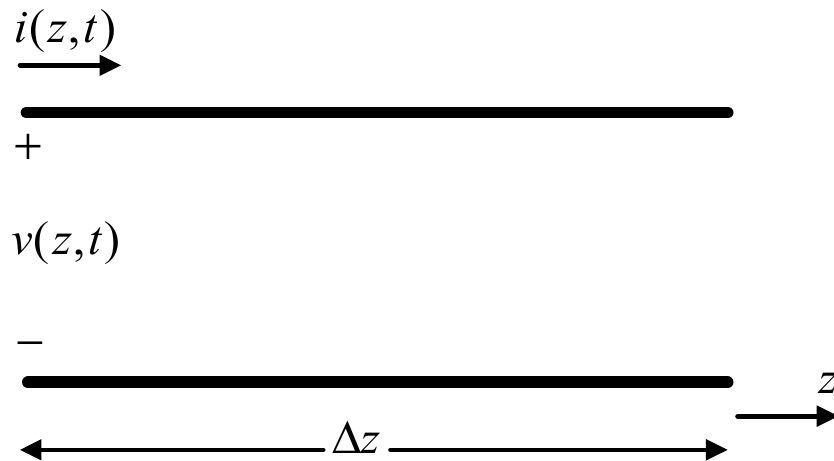
Figure 6. The illustration of the transmission line.